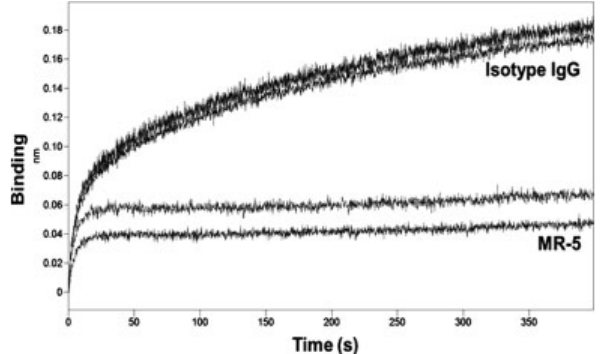
Fig. 5 Binding of VWF/ULVWF (ULVWF) to C3 protein is blocked by anti-A3 domain antibody. Biosensors coated with C3 were dipped onto wells containing a solution of ULVWF mixed with mouse IgG (25 μ g/mL) or anti-VWF A3 domain antibody, MR-5 (25 μ g/mL). The MR-5 antibody inhibited (cid:1) 70% of the ULVWF – C3 binding. The graph shows two separated